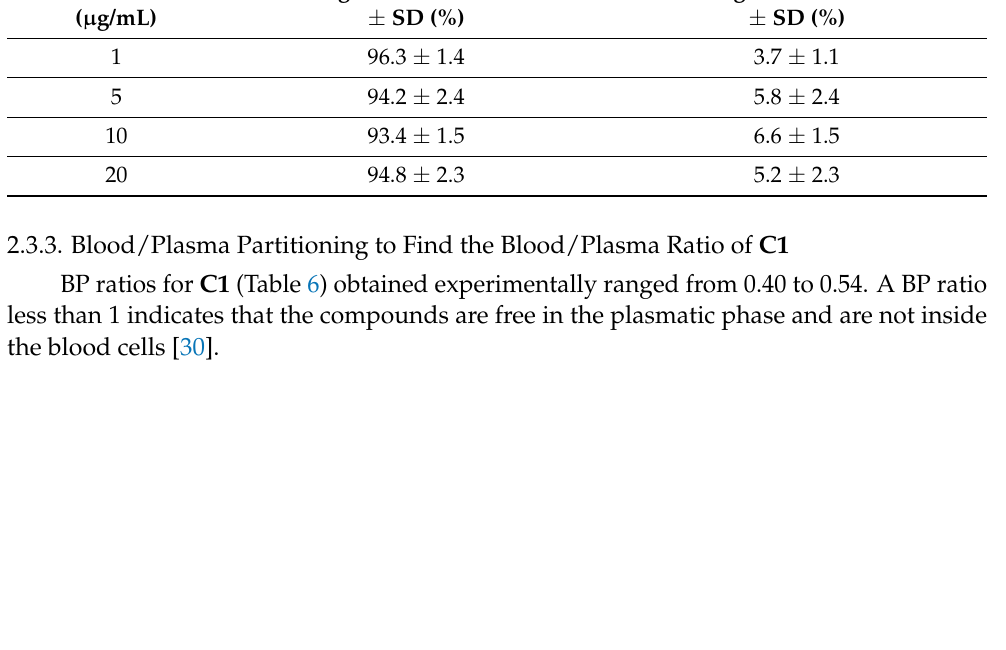
Table 5. The percentage of the bound and unbound fractions of C1 in rat plasma ( ± SD). The plasma protein binding assay was carried out by RP-HPLC with the ultrafiltration method at a concentration of 1, 5, 10, and 20 µ g/mL of C1 in the plasma of Wistar rats.